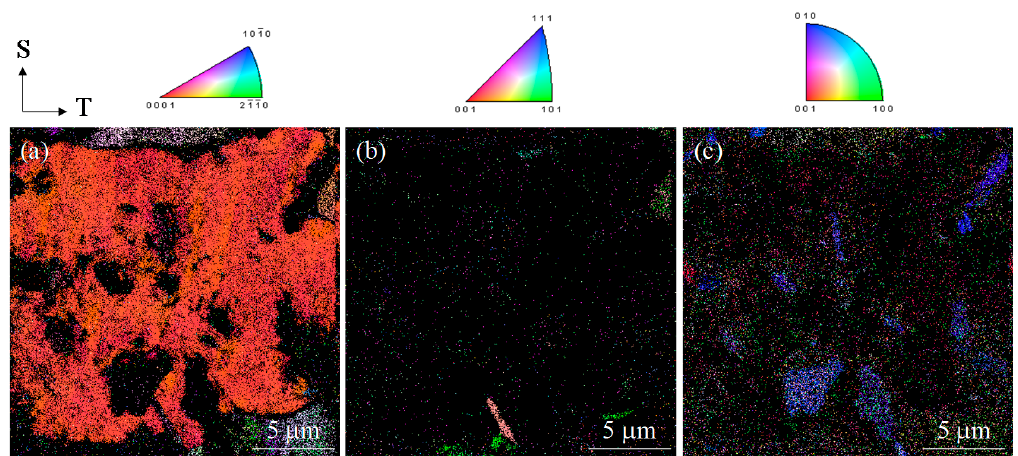
Figure 3. Inverse pole figure maps obtained by electron backscatter diffraction (EBSD) analysis for TiB/Ti-3Al-2.5V composites indicating the crystallographic orientation to the normal plane for ( a ) -Ti, ( b ) -Ti, and ( c ) TiB.